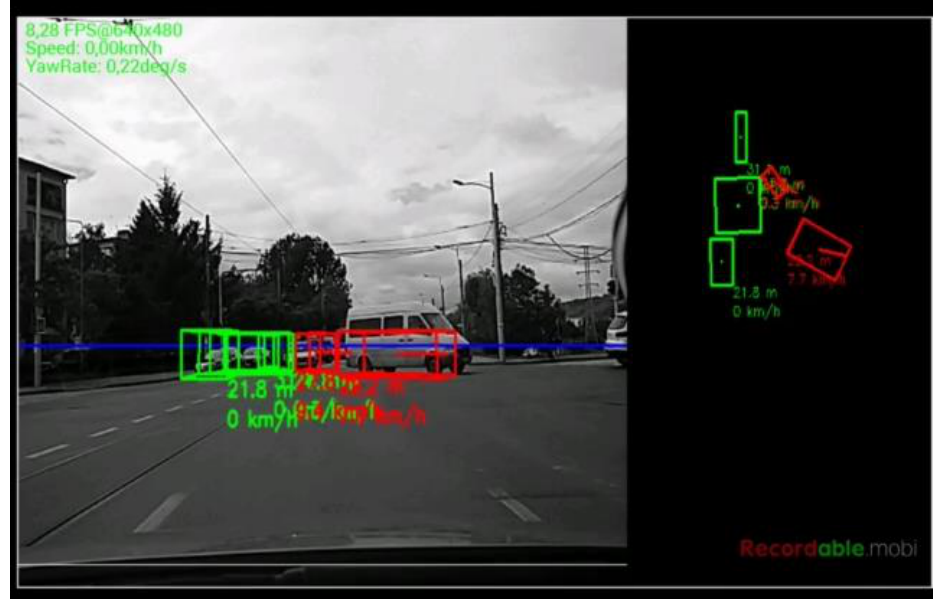
Figure 18. Obstacle detection on the Samsung Galaxy Tab Pro, waiting to cross an intersection: ( Left ) perspective projection of the detection results; and ( Right ) top view of the detected obstacles.